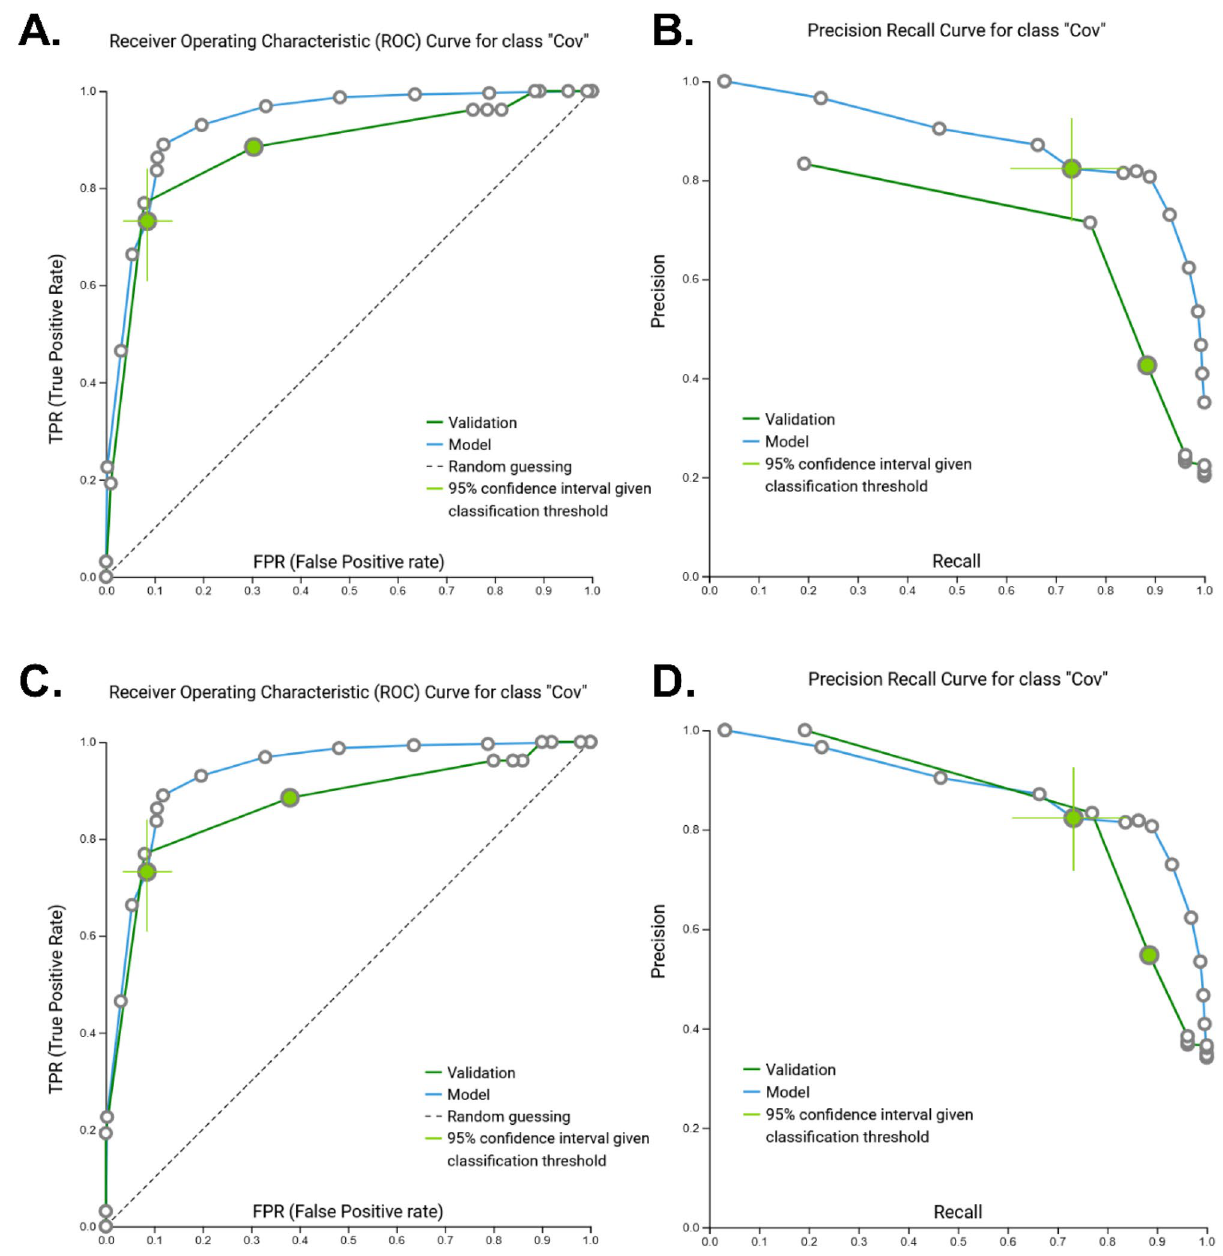
Figure 3. Model performance (external validation). Receiver-operating characteristic (ROC) and Precision- Recall curves (PRC) for the validation of the artificial intelligence-based classification model to identify patients with COVID-19 disease. AUC area under the curve; “Cov” COVID-19 disease classification. Colored circle represents the optimized classification threshold to predict COVID-19 disease, while bars extending from the circle represent 95% confidence. ( A,B ) AUC-ROC = 0.901 and AUC-PRC = 0.965 for the complete external validation dataset. ( C,D ) AUC-ROC = 0.898 and AUC-PRC = 0.864 when non-ICU COVID-19 patients were removed from the external validation